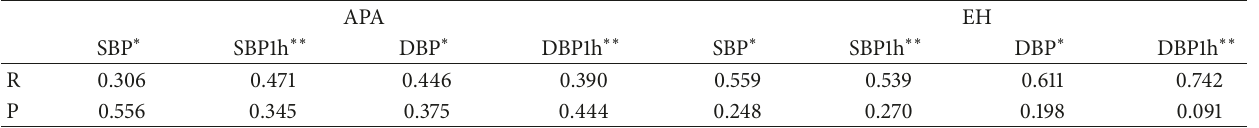
Figure 3: Pearson correlation of plasma aldosterone concentration and blood pressure ((a) systolic, (b) diastolic) for each patient . The x-axis represents the P-value yielded according to Pearson’s correlations. The dotted line indicates P = 0.05. Most P-values were higher than 0.05 (distributed to the right of the dotted line). Note: each triangle represents a specific patient. A hollow triangle represents a patient with EH and a solid triangle represents a patient with APA. Table 3: Linear correlation of plasma aldosterone concentration and blood